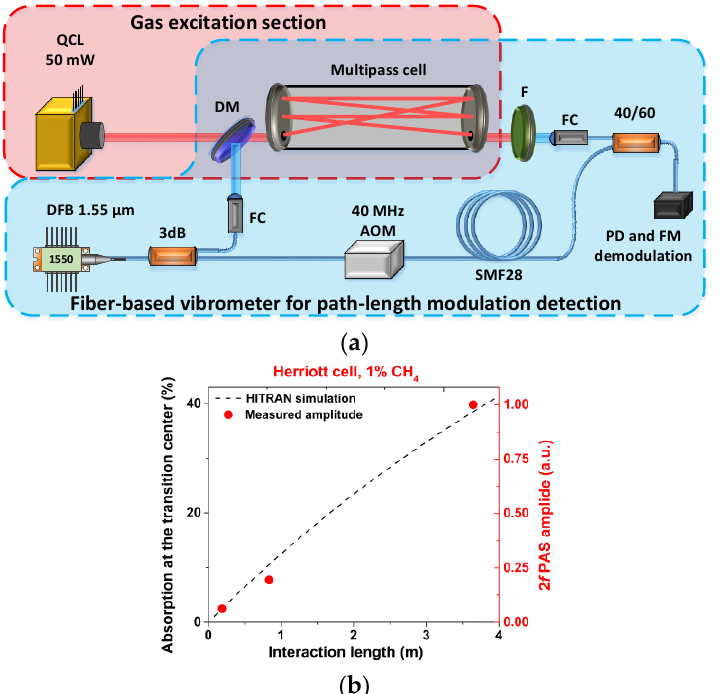
Figure 6. ( a ) Schematic of the experimental layout incorporating a multi-pass cell for interferometric detection of a PA signal. X0/Y0 — fiber couplers with specified splitting ratio, DM — dichroic mirror,